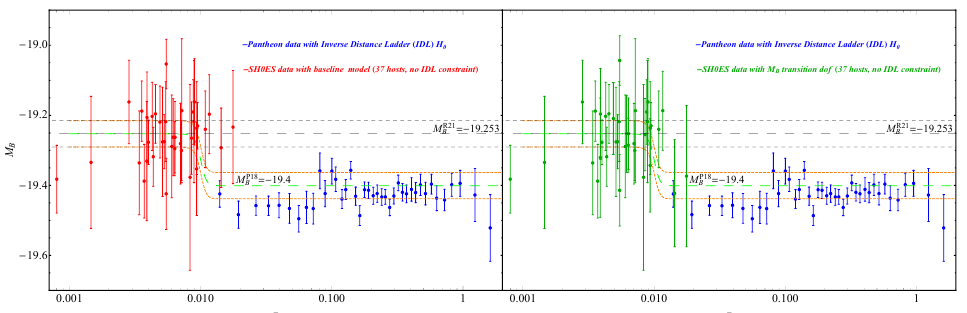
Figure 16. The mean SnIa absolute magnitude M Bi for each Cepheid+SnIa host i obtained from Equation (36), obtained using the SH0ES baseline model (left panel) and the M B transition model (right panel), which allows (but does not enforce) an M B transition at D c = 50 Mpc. Notice that when the M B transition degree of freedom is allowed in the analysis, the best-fit values of M Bi for the more distant hosts N0976 ( D = 60.5 Mpc) and N0105 ( D = 73.8 Mpc) spontaneously drop to the inverse distance ladder calibrated value range (green points with z >